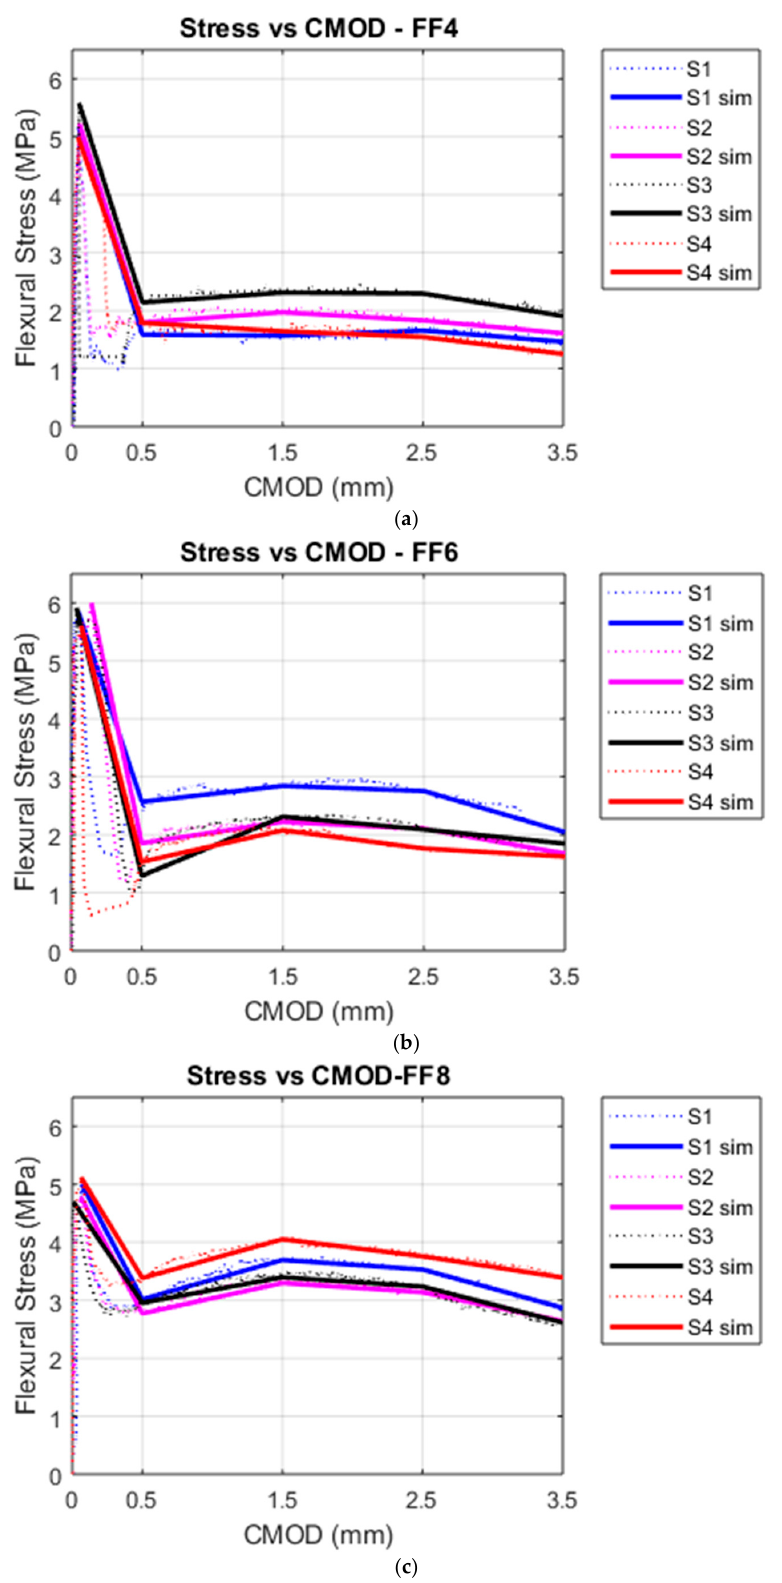
Figure 8. Flexural stress vs. CMOD plots for ( a ) FF4, ( b ) FF6 and ( c ) FF8, along with the corresponding line connecting maximum stress to stress at CMOD1, CMOD2, CMOD3, and CMOD4 .